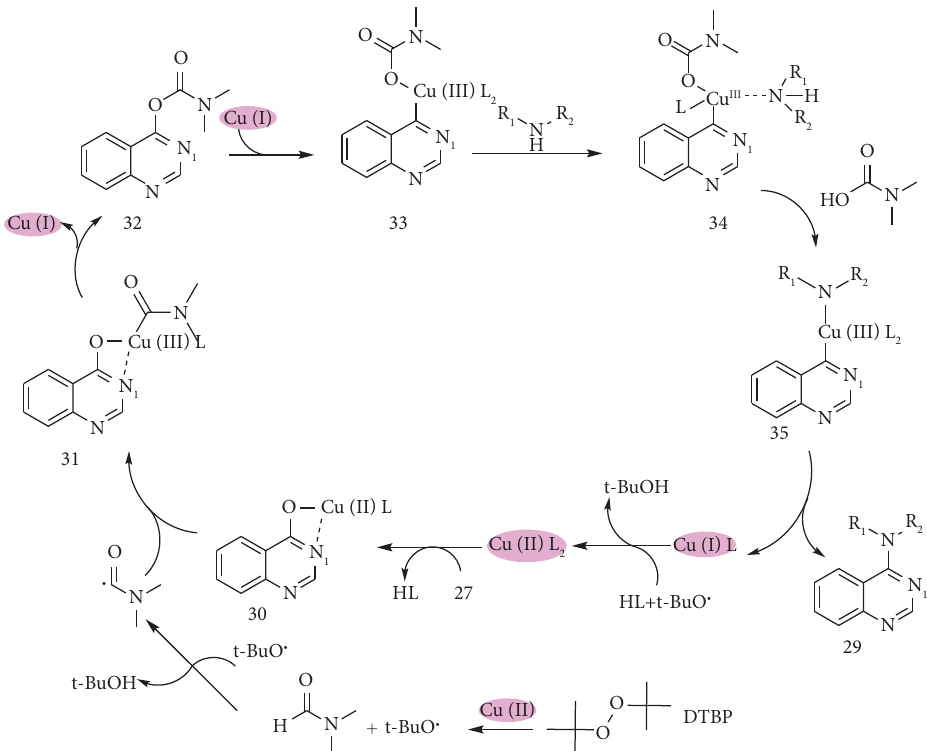
Figure 6: Te proposed mechanism for the synthesis of 4-aminoquinazoline derivatives in the presence of Cu(acac)